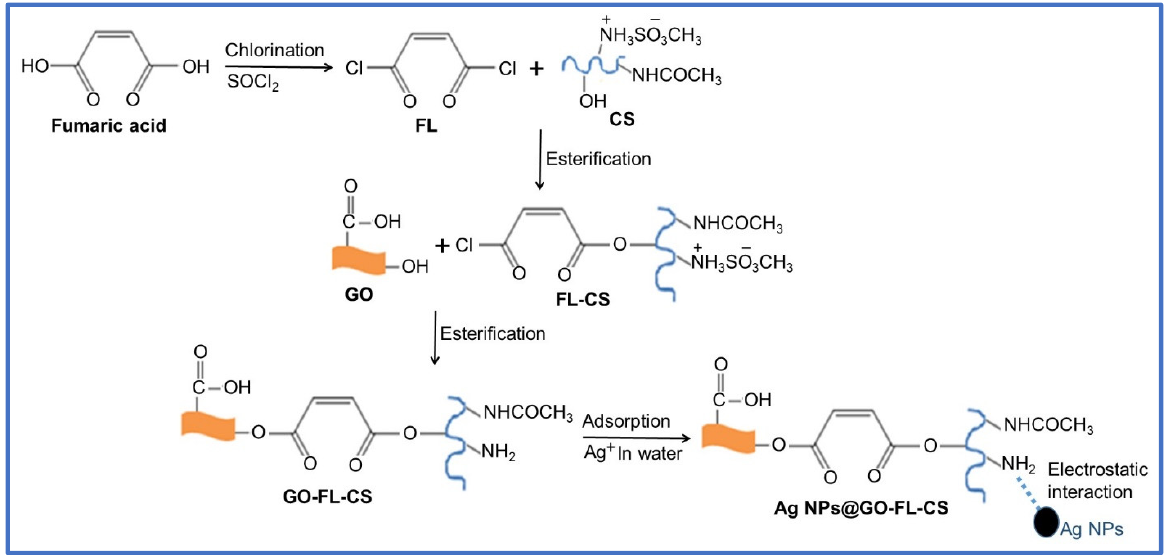
Scheme 1. Schematic diagram for the fabrication of Ag